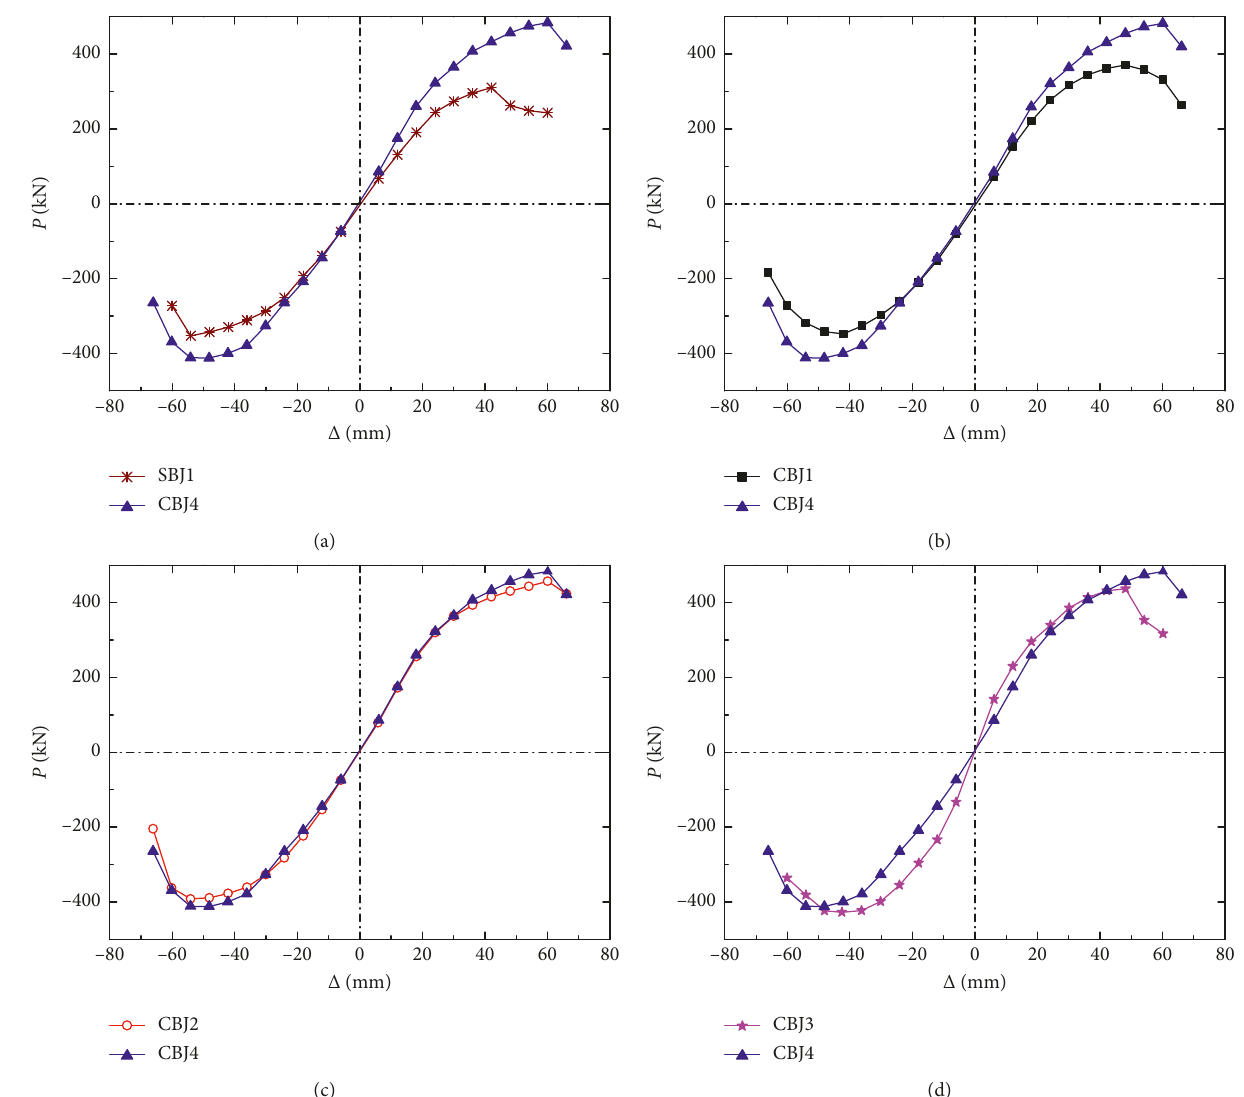
Figure 15: P - envelope curves of the specimens: (a) effect of the RC slab; (b) effect of the stiffening of the web anchorage plates; (c) effect of the infilled concrete; (d) effect of the thickness of the RC Δ